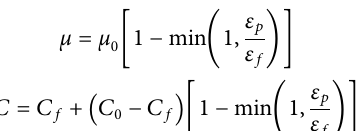
Frontiers in Earth Science |